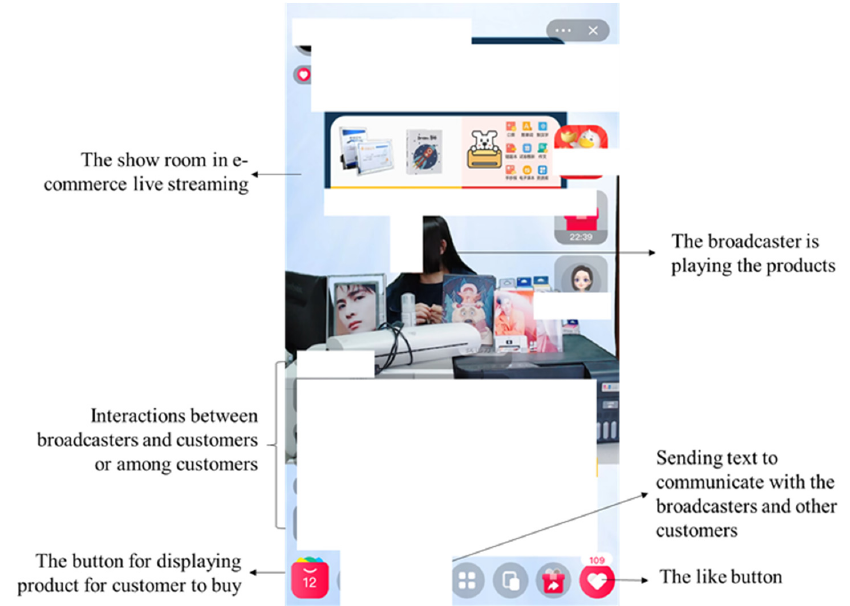
Figure 2. Screenshots of live streaming e-commerce on Taobao Live.